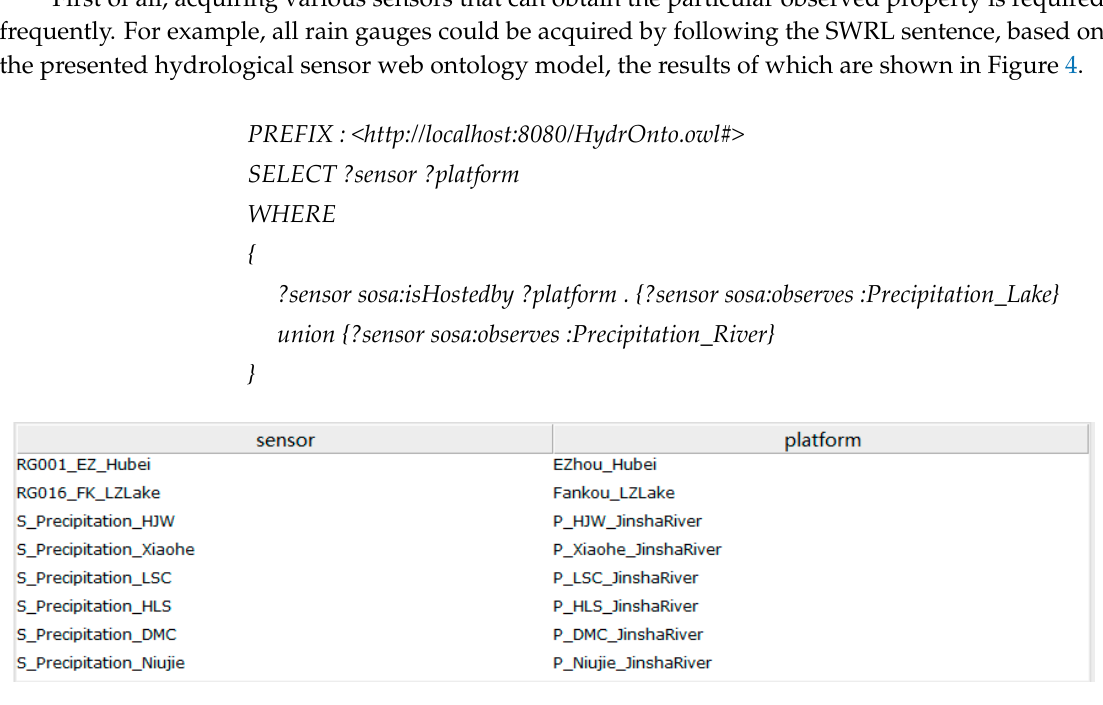
Figure 4. The search result of sensors observing precipitation and the platforms on which these sensors are deployed.